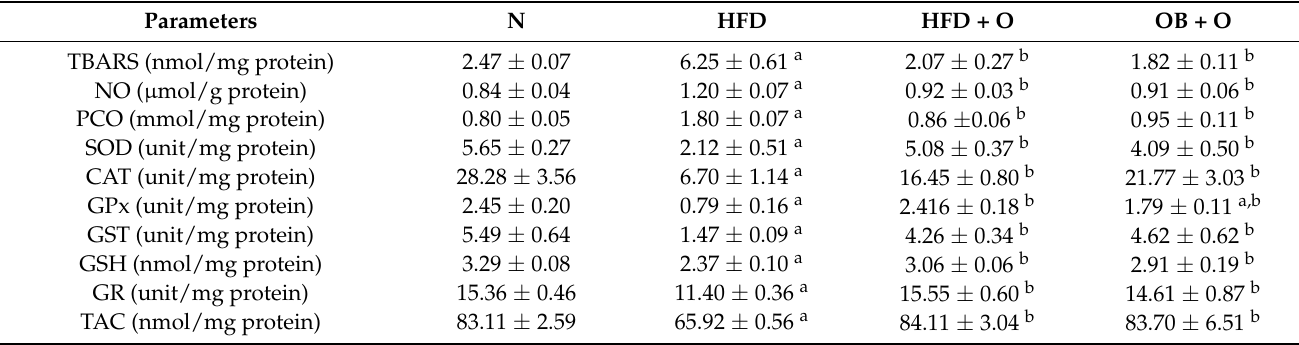
Table 4. Liver oxidative stress and antioxidants